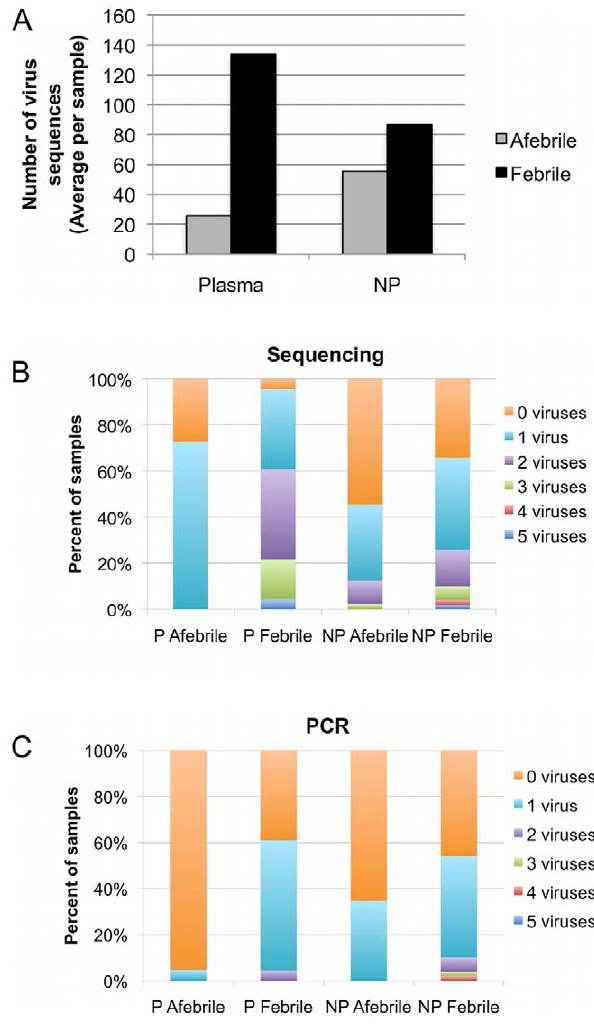
Figure 5. Febrile children have more viral sequences from a greater range of viruses than do afebrile children. The number of sequences was scaled to 3 million per sample before comparisons were made between groups. (A) The average numbers of viral sequences found in plasma and NP samples from the subjects are represented by gray bars for samples from afebrile children and black bars for samples from febrile children. The percentage of samples in each group for which 0, 1, 2, 3, 4, or 5 viruses was detected is plotted for (B) sequencing data and (C) PCR data. doi:10.1371/journal.pone.0027735.g005 PLoS ONE |